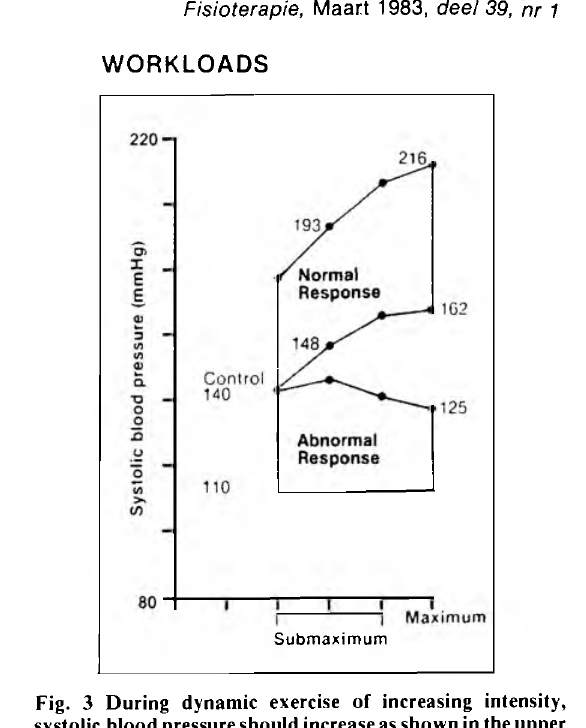
Fig. 3 During dynamic exercise of increasing intensity, systolic blood pressure should increase as shown in the upper shaded area of this figure. Failure of the systolic blood pressure to rise normally during a progressive exercise test indicates severely compromised heart function and is an absolute indication to terminate the exercise test without delay. Data after Wolthuis et ah Circulation 1977, 55, 153-157. of 0.5 mm is first noted at a heart rate of approximately 112 beats/min. This progresses to 1 mm ST segment depression at a heart rate of about 135 beats/ minute, at which point the patient complains of mild, but distinctive, angina pectoris. At a heart rate of 150 beats/minute, the ST segment depression equals 2 mm and shortly thereafter the patient complains of marked angina, and the test is terminated. (This illustration shows that ST-segment changes may precede the onset of angina. Many authorities would advislj that a stress test should be terminated when ST levels are depressed by 2 mm.) From the results of this adequate, symptom-limited maximum exercise test, it is now possible to safely prescribe exercise for this patient. Our approach is to prescribe exercise at up to 90% of